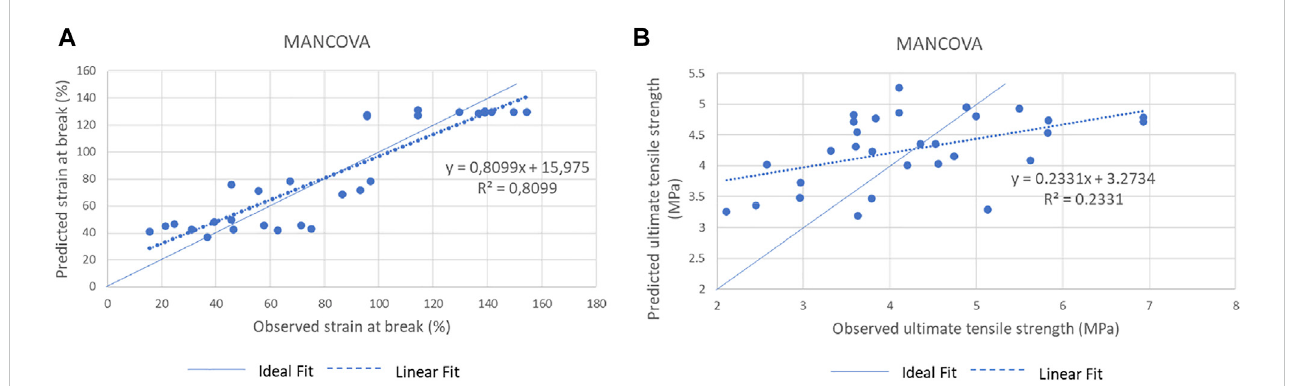
FIGURE 10 Observed values vs. predicted values with MANCOVA: (A) strain at break (%) vs. predicted strain at break (%) and (B) observed ultimate tensile strength (MPa) vs. predicted ultimate tensile strength